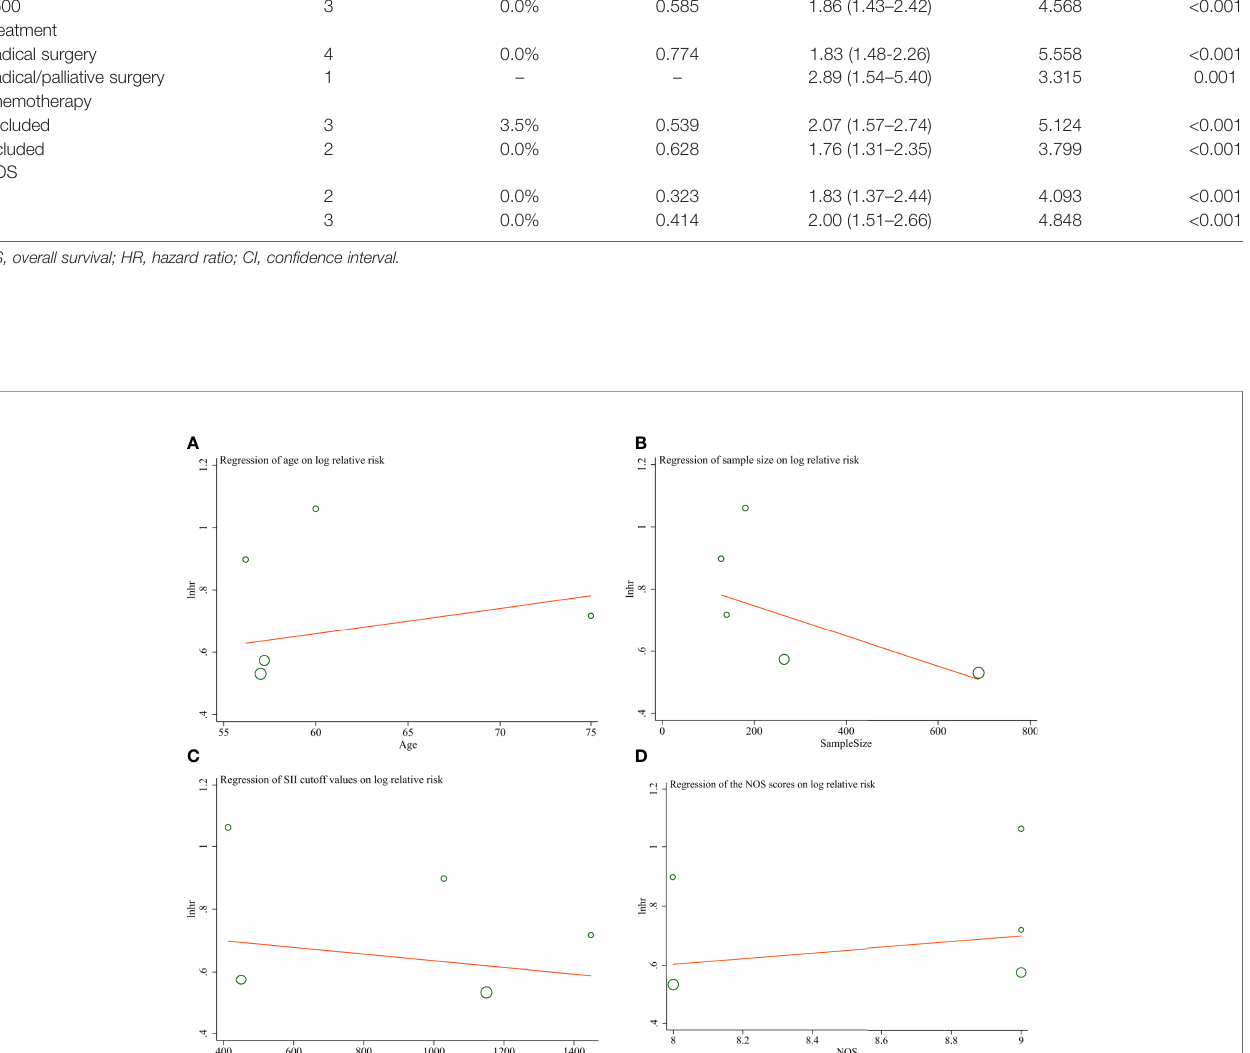
Frontiers in Oncology |